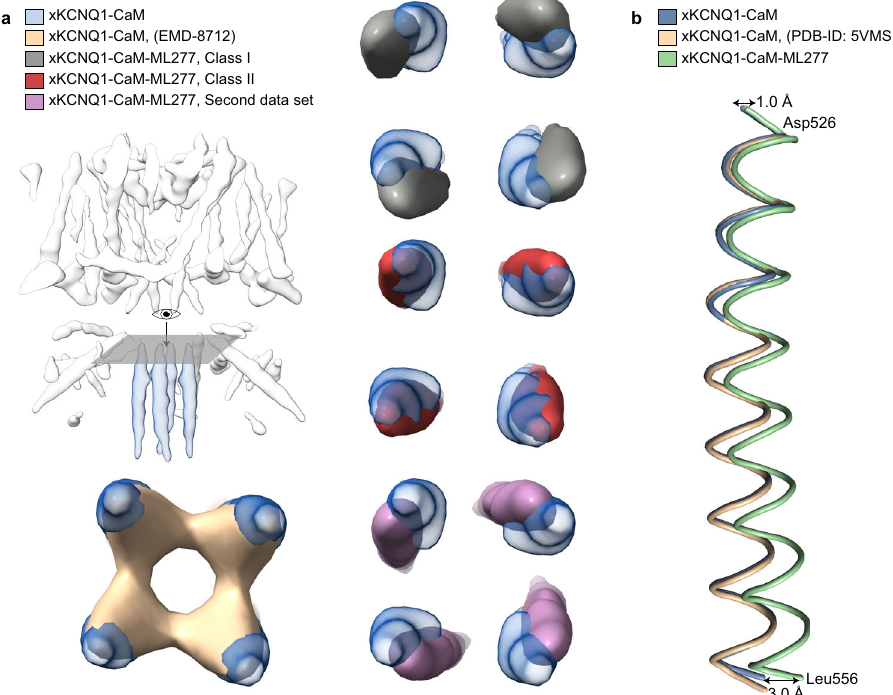
Fig. 3 xKCNQ1-CaM-ML277 shows a twisted coiled-coil C-terminal domain. a Heterogeneous re fi nement ( K = 4) of xKCNQ1-CaM-ML277 data set 1 showed three KCNQ1 classes (see Supplementary Fig. 3). Two classes with similar twist were pooled and re fi ned shown here as class I whereas the third class is shown as class II for clarity. Both classes have different CTD twist degrees between them, and compared to our native and previously studied xKCNQ1-CaM map (PDB-ID: 5VMS), indicating a fl exibility in the ML277-induced twist of the coiled-coil CTD. The native structure which was determined in this work is shown in light blue. This twist was also observed for the xKCNQ1-CaM-ML277 data set 2. b The twist of the CTD in the ML277-bound xKCNQ1-CaM (light green) compared to our and previously studied native structures (blue and brown, respectively) shows a displacement of the backbone by ~1 Å at the top of the CTD (Asp526) and due to the propagated twist up to ~3 Å around the last modeled residue,